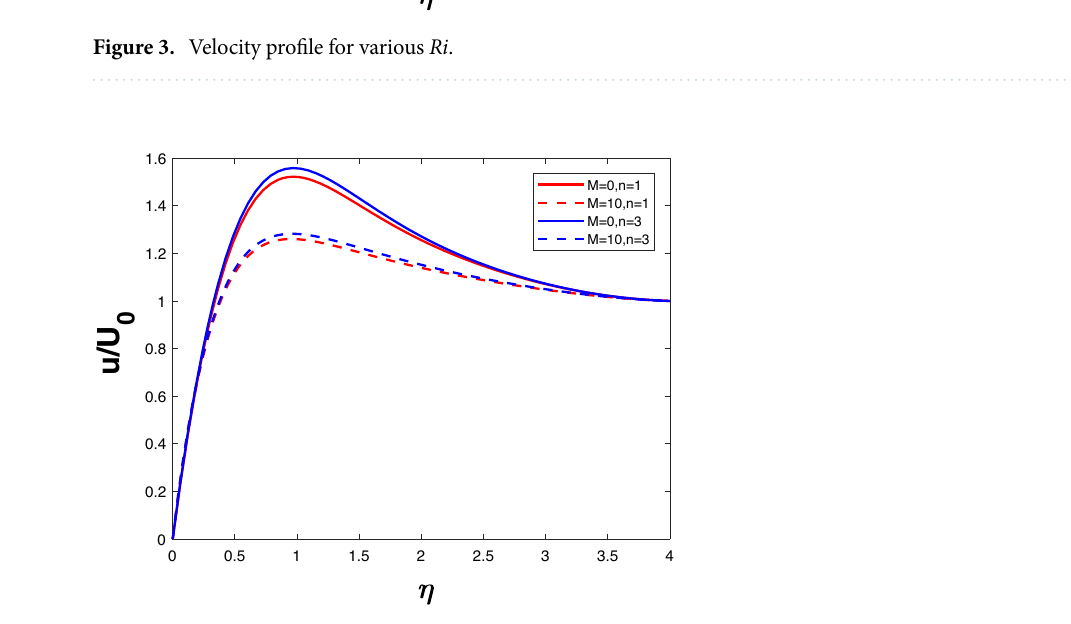
Figure 4. Velocity profile for various M